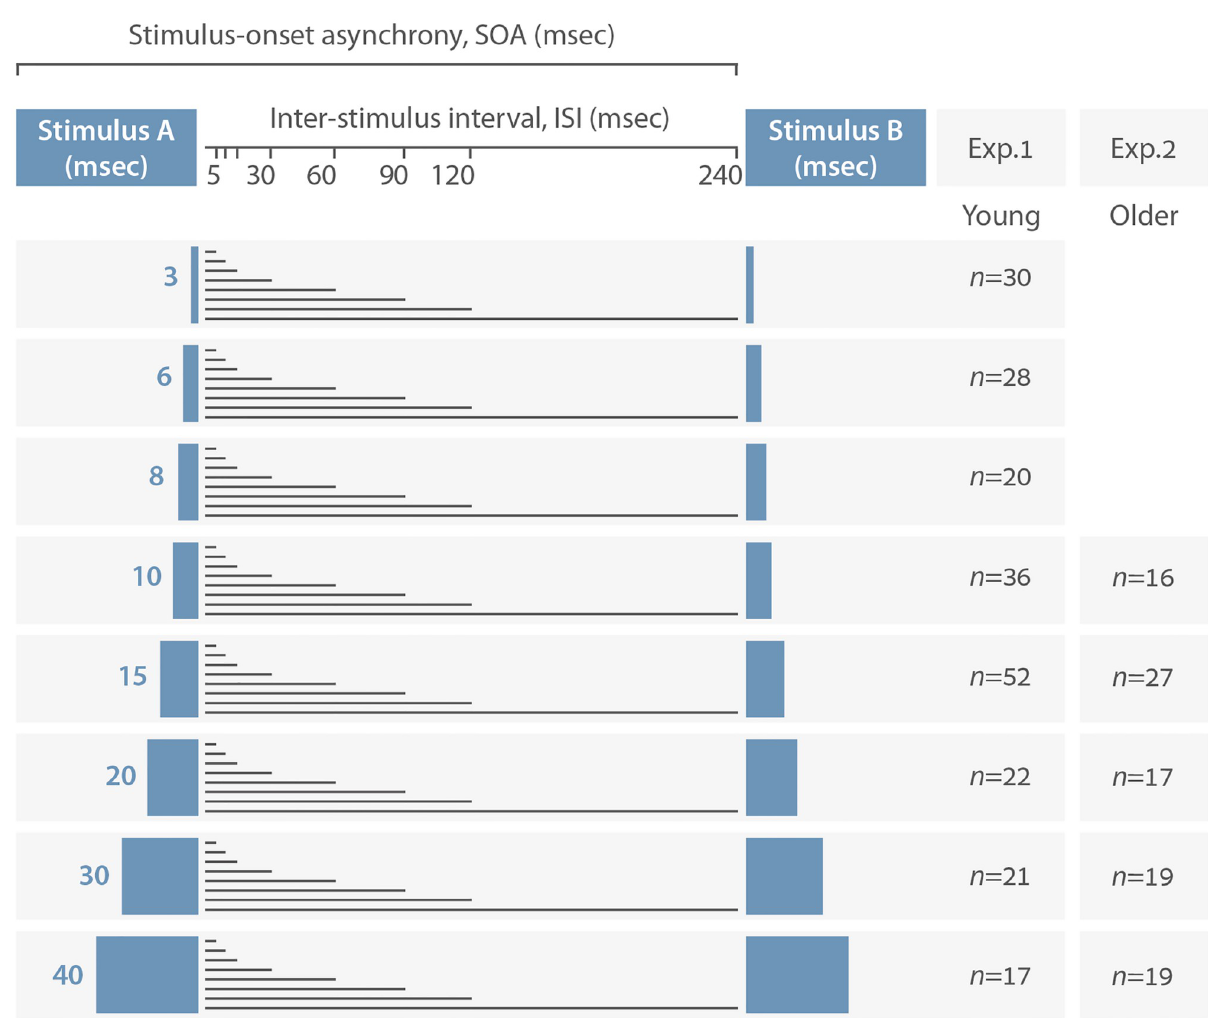
Fig 1. Schematic illustration of study design demonstrating the relationship of stimulus duration, inter-stimulus interval (ISI), and stimulus- onset asynchrony (SOA) (see top line). The manipulation of stimulus duration is presented as the duration of Stimulus A and Stimulus B, which varied across groups in the current study as a between-subjects variable. ISI is presented as the silent gap between the offset of Stimulus A and the onset of Stimulus B, which varies within each group as a within-subjects variable. Numbers of participants in each group for Experiments 1 and 2 are shown. a . Data by duration and ISI. b . Data by